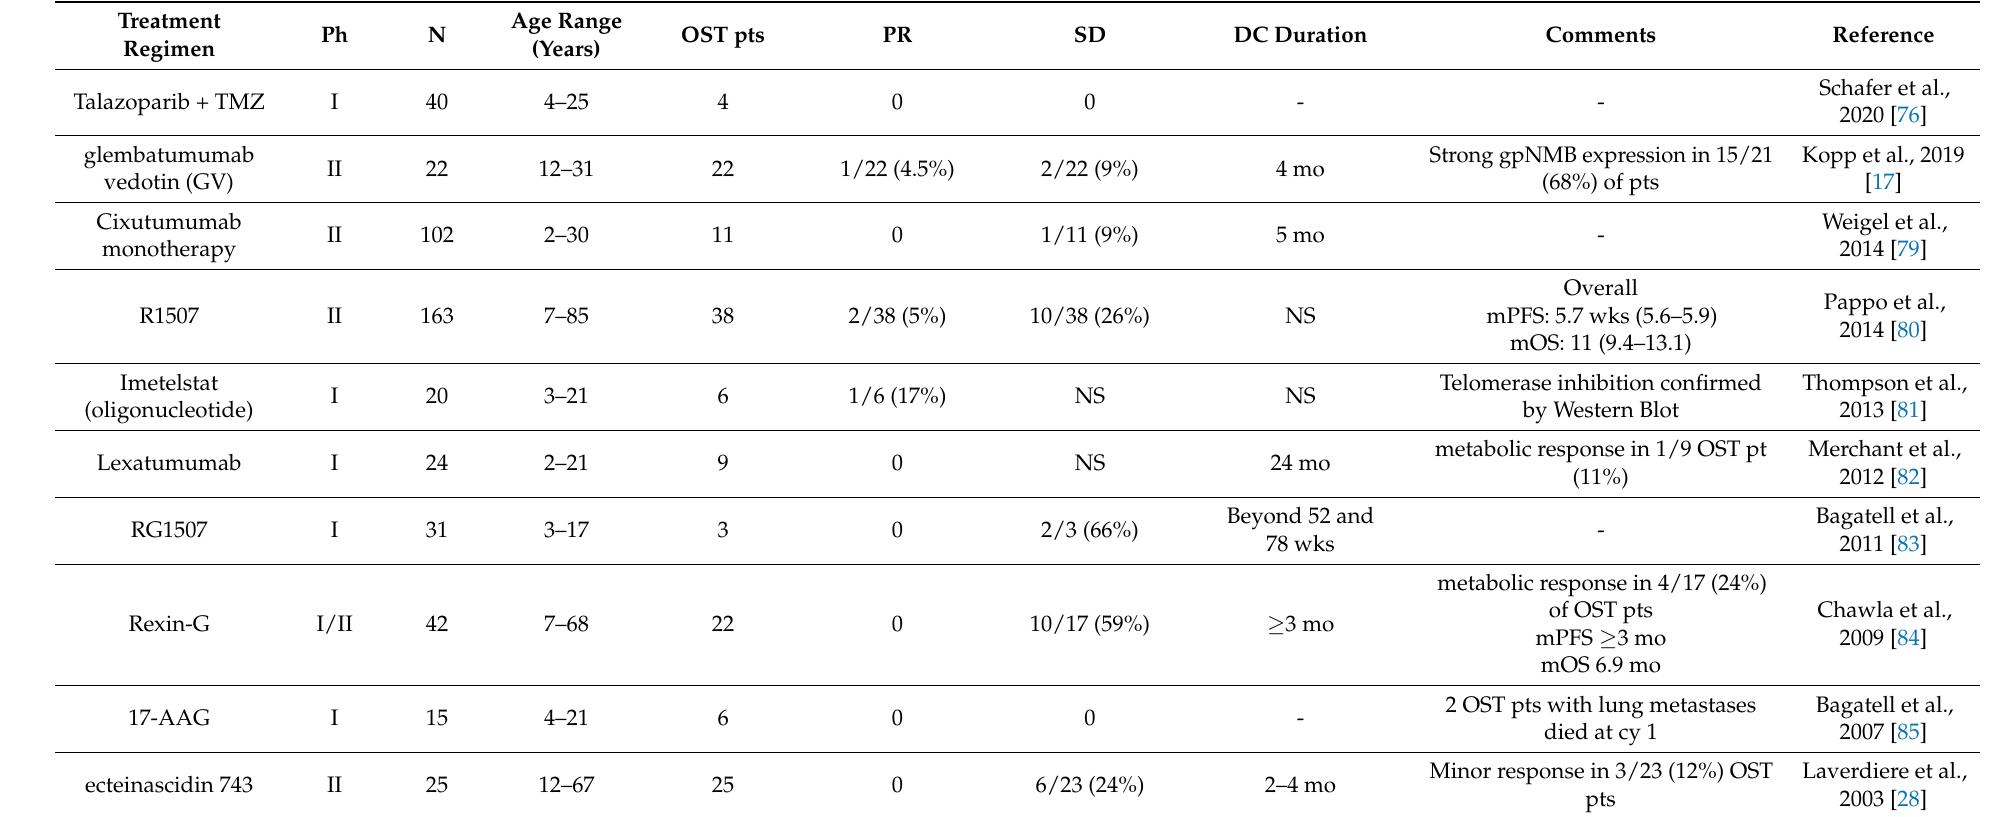
Table 5. Targeted agents—Miscellaneous (10